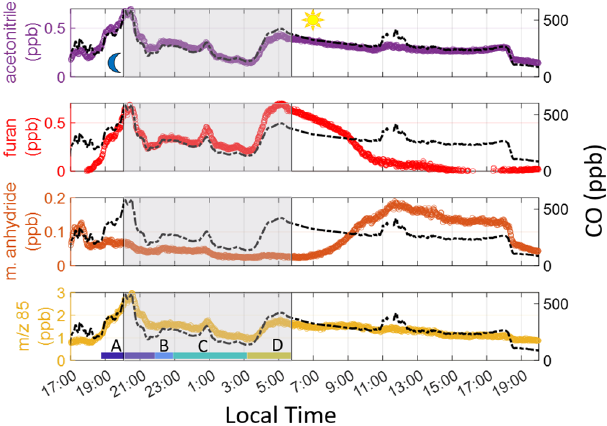
Figure 2. VOCs and CO on 3–4 February 2020 with the shaded area representing sunset to sunrise. The peak in CO after sunset (start of gray-shaded area) is used to denote the beginning of the smoke event. We limit our analysis to sunrise on the following day. The color labels A–D indicate individual times used to calculate ERs (see Sect. 5.2 in main text). m/z 85 in the bottom time series indicates the sum of furanone and